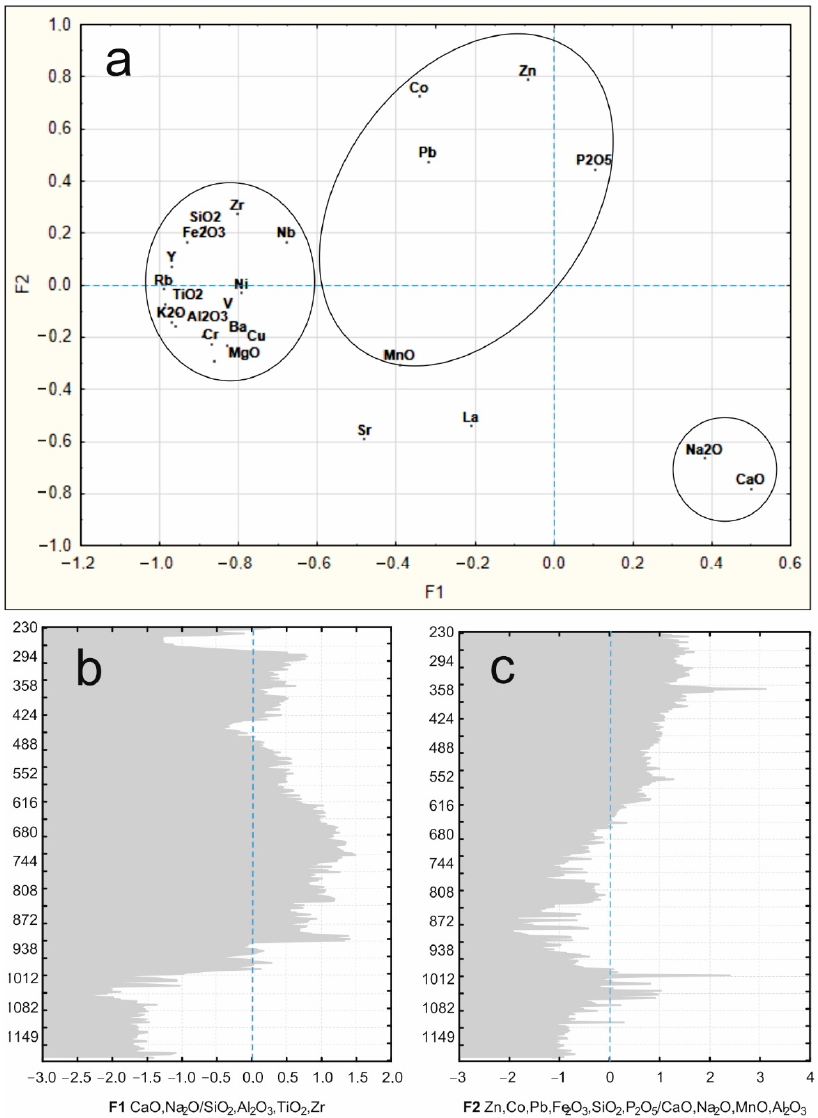
Figure 3. Results of PCA: ( a ) biplot, ( b ) dynamics of the first factor, ( c ) dynamics of the second factor.